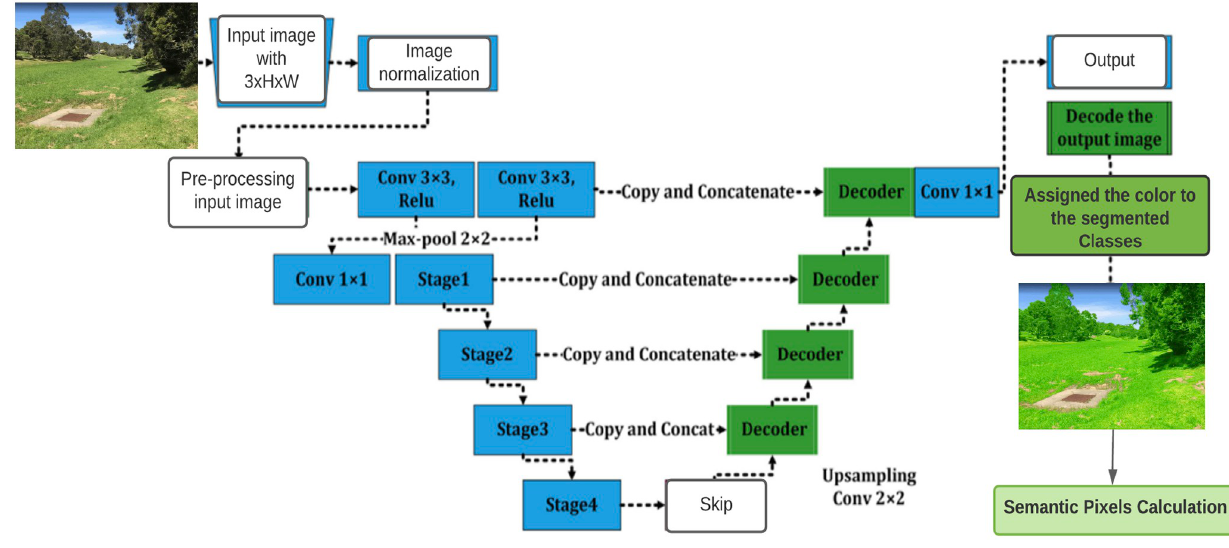
Fig 5. The architecture of U-Net shows network